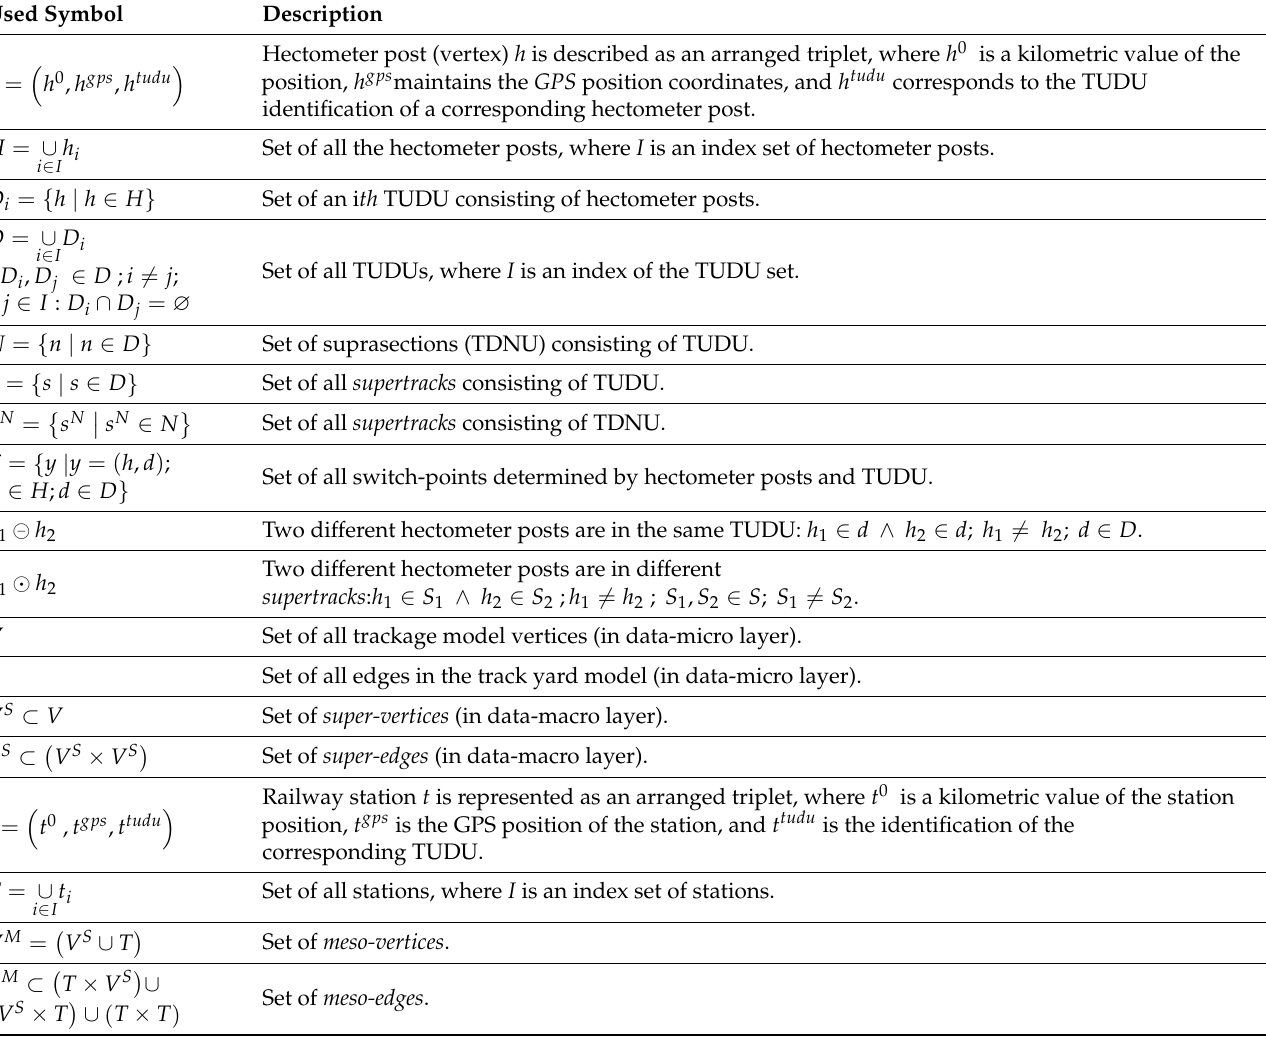
Figure 4. Illustration of a three-layer model.